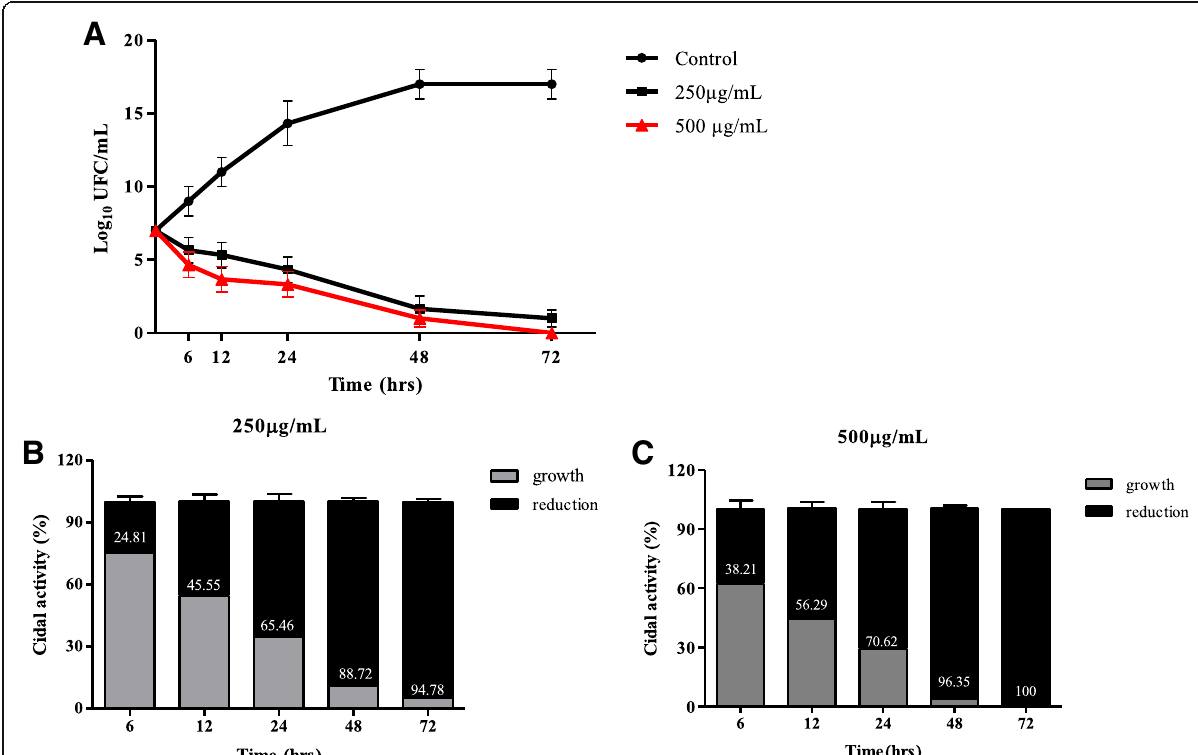
Fig. 5 Bacterial- time kill curve. Zerumbone was tested for antimicrobial activity on bacterial-kill kinetics. S. mutans were grown in BHI broth + tween 20 10% (control) or along with graded concentrations of zerumbone at 37 °C for 72 h in anaerobic conditions. Samples were collected at different time intervals to estimate bacterial kill kinetics ( a ) and growth reduction ( b and c ), by spectrophotometry analysis and CFU counts. Numbers inside of bars at ( b ) and ( c ) figures means percent reduction. Results are representative of three independent experiments and data are expressed in mean ± SD. The interquartile range of each data is indicated by error bars